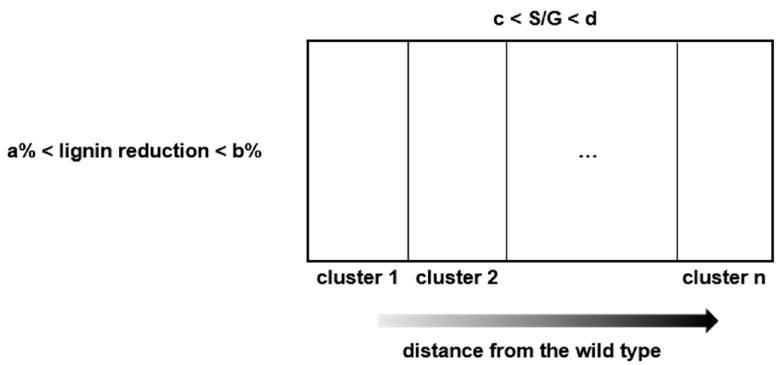
Figure 9. Clusters of results in matrix subpanels of Figure 8.